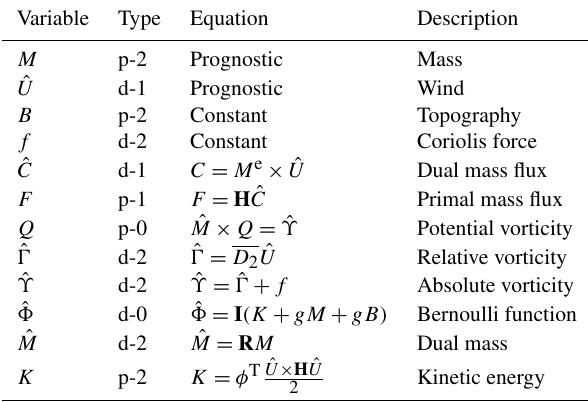
Table E1. List of discrete C- grid variables and their diagnostic equations.